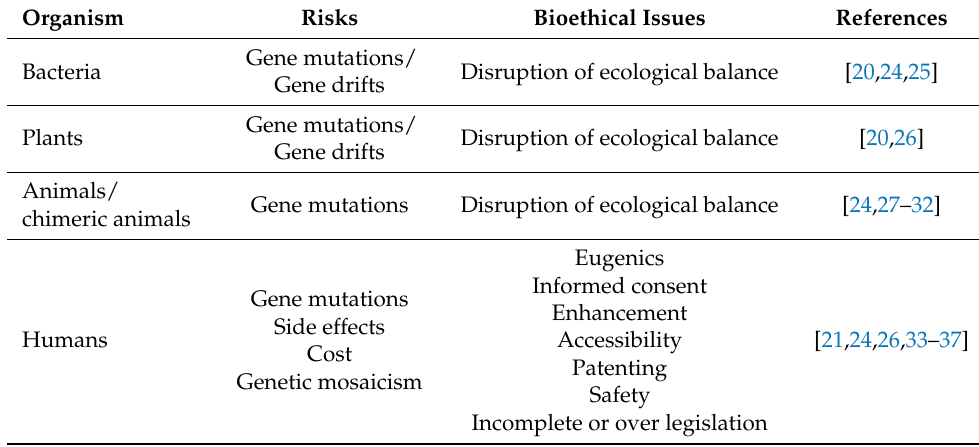
Table 2. Some of the bioethical issues and possible risks intended for the application of the CRISPR- Cas9 system.